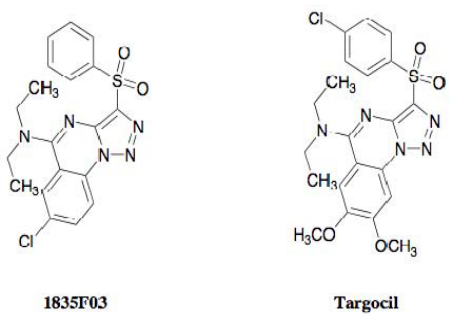
Figure 11. Structures of 1835F03 and